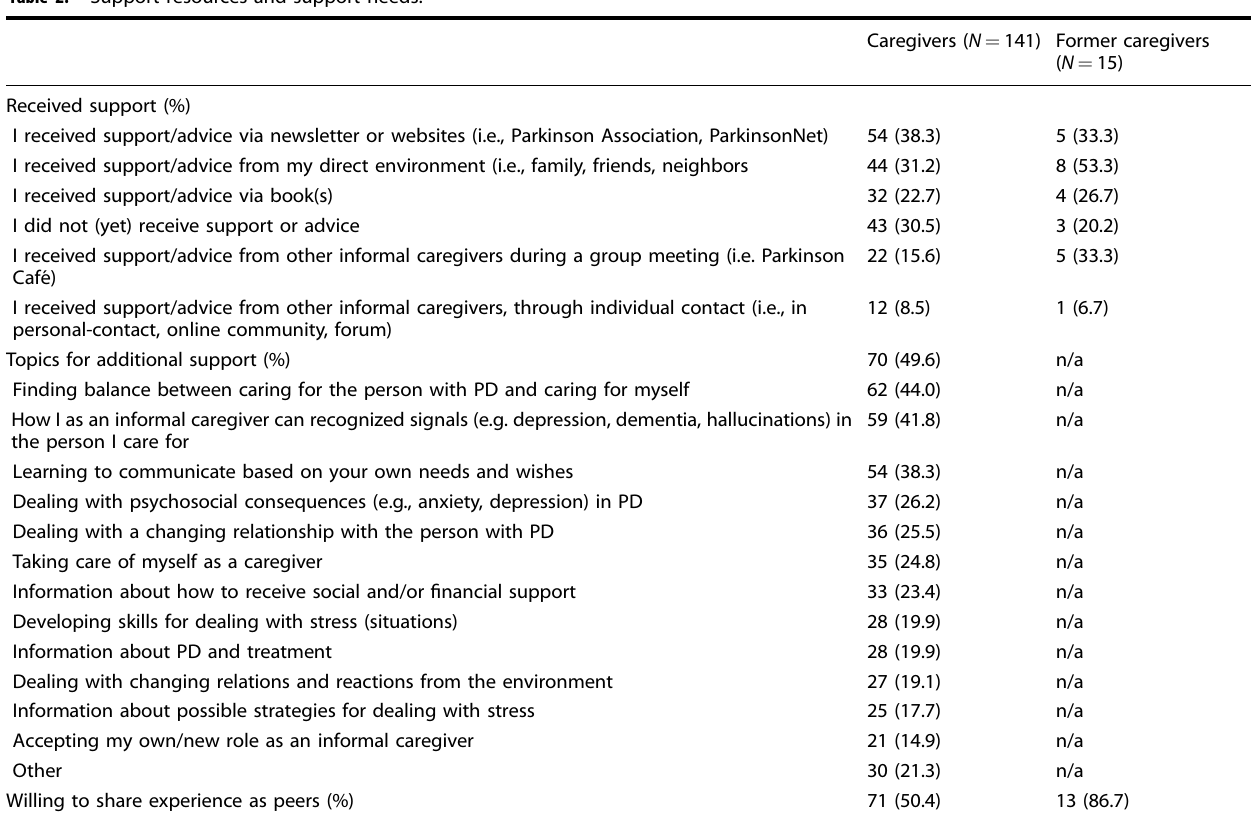
Table 2. Support resources and support